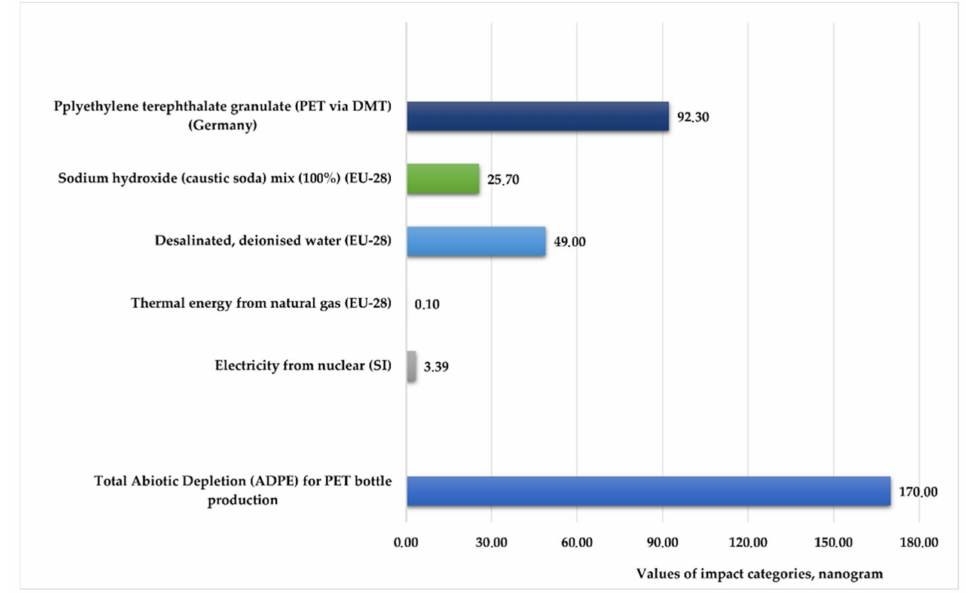
Figure 8. Abiotic depletion values for elements (ADPE) during PET bottle production. (Functional unit: 4 kg PET product. Normalization reference: CML 2016, EU 25 + 3, year 2000, excl. biogenic carbon. Weighting method: thinkstep LCIA Survey 2012, Europe, CML 2016, excl. biogenic